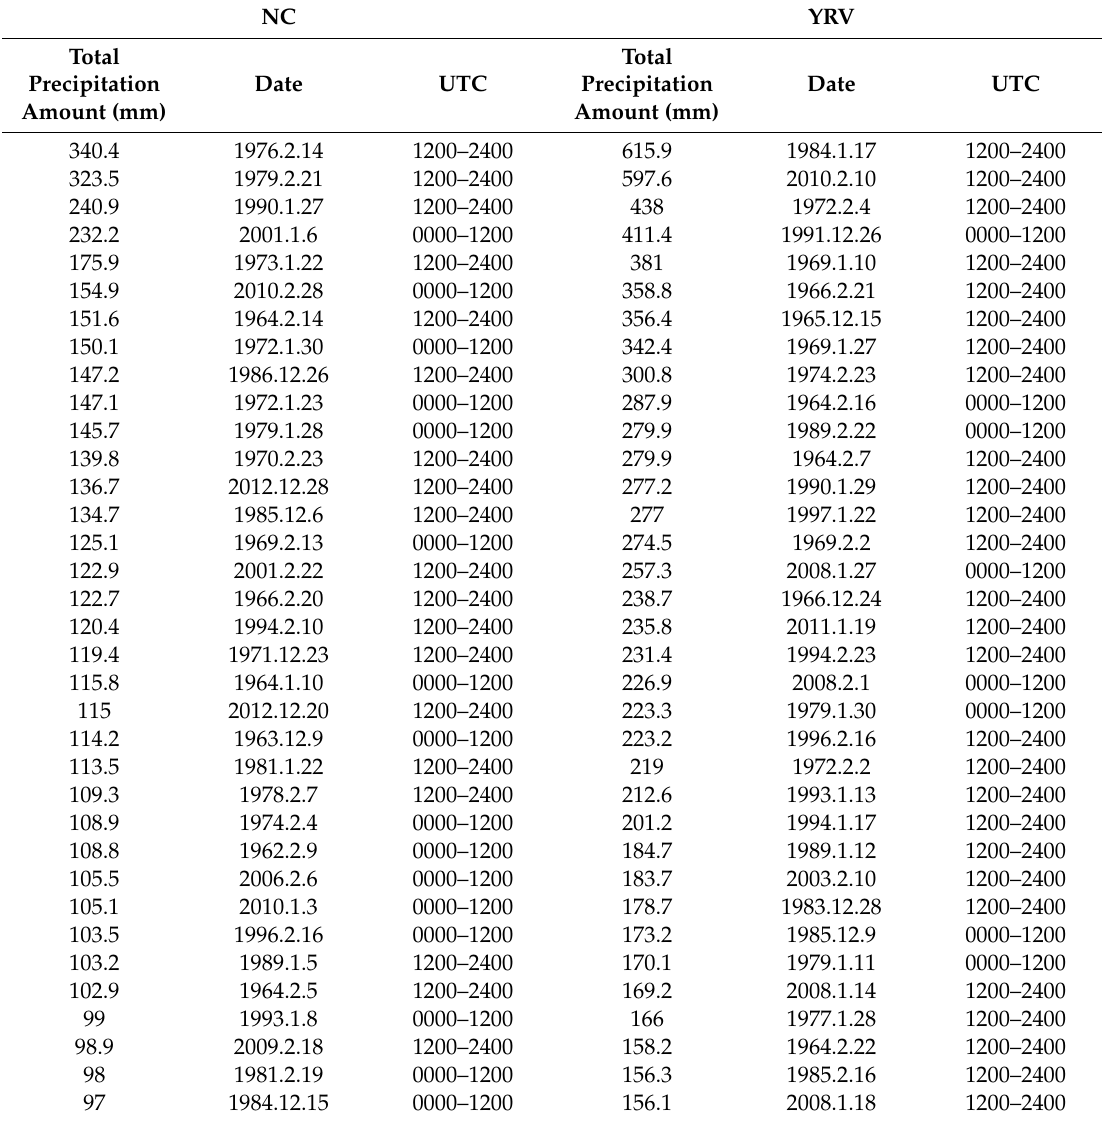
Table 1. The 70 intensive snowfall event (ISE) cases in North China (NC) and 40 ISE cases in the YRV region used for the composite analysis. The cases are sorted by the total precipitation amount of stations in the target